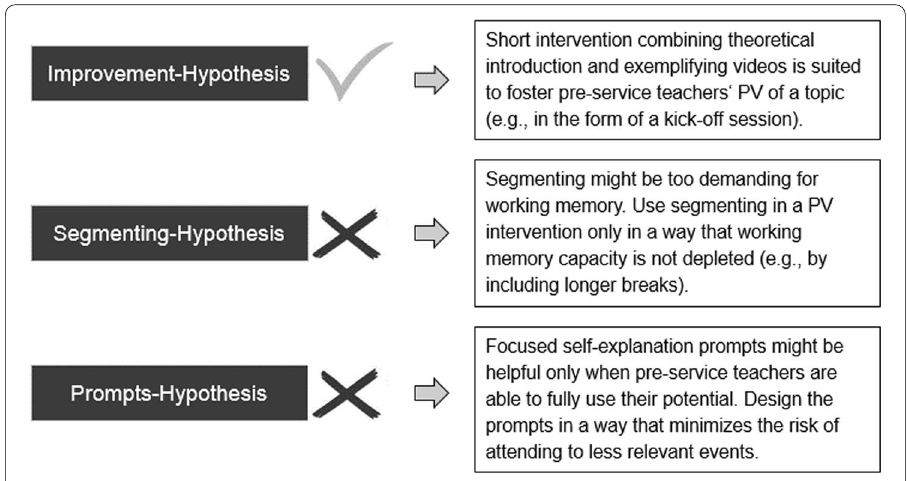
Fig. 5 Summary of the results and main